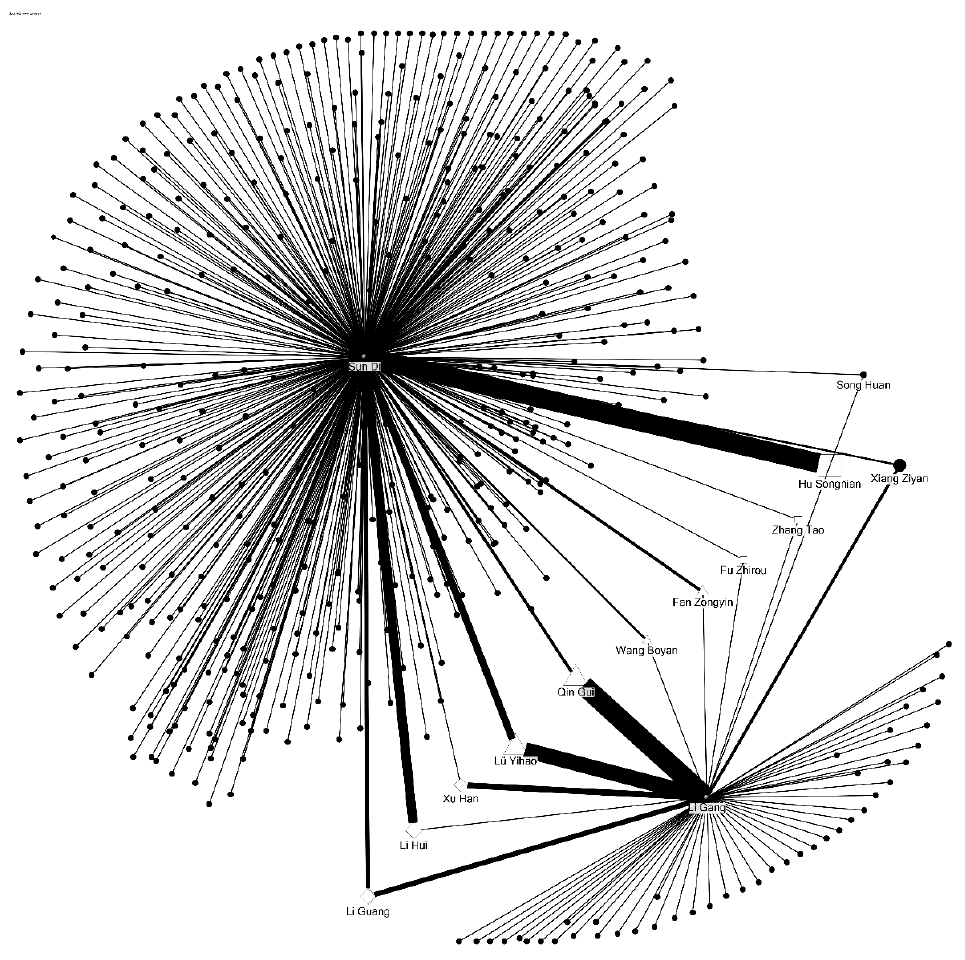
Figure 1. The Epistolary Networks of Sun Di and Li